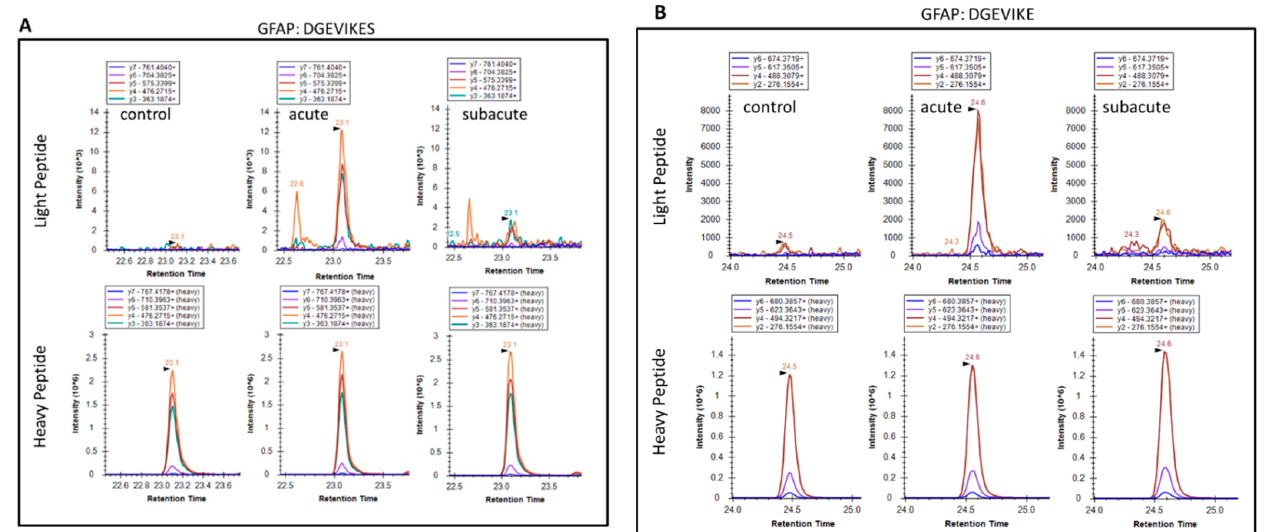
Figure 10. Targeted LC/MS/MS extracted ion chromatograms for light and heavy versions of GFAP peptides in control and in acute and subacute time points: ( A ) DGEVIKES and ( B ) DGEVIKE. Heavy peptides were spiked in at 20 fmol/50 uL of pooled CSF before ultrafiltration with a 10 kDa membrane. Pooled CSF samples were generated by pooling 10 uL of each sample type (control, n = 14; acute TBI, n = 15; subacute TBI, n = 13) from the available CSF samples. The data shown are for a single analysis of each pooled sample type.